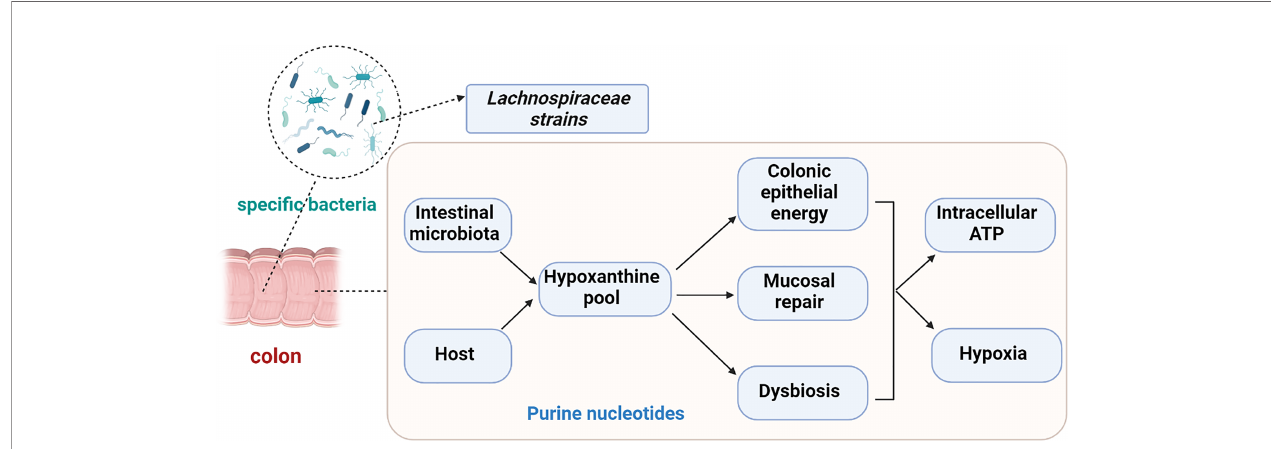
FIGURE 2 | Purine starvation in colonic epithelium as a potential novel mechanism underlying IBS due to depletion hypoxanthine pool. Hypoxanthine might cause irritable bowel syndrome (IBS) symptoms via colonic epithelial energy, the capacity for mucosal repair or dysbiosis. Decreased fecal hypoxanthine abundance were most strongly associated with Lachnospiraceae